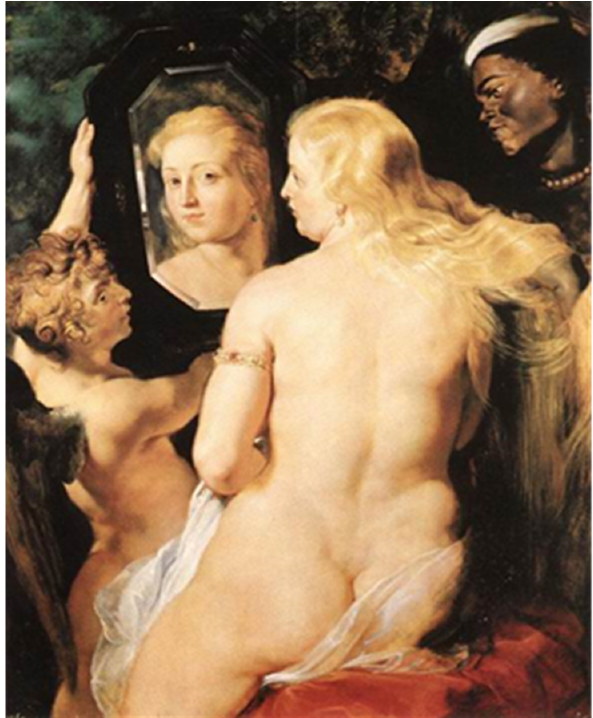
Peter Paul Rubens (Figure 3: “Venus at a Mirror,” 1615; http://rybens.ru/woman/ru- bens2.php (accessed on 25 September 2022): she is portrayed from behind in profile, and in the mirror her face is in full-face;